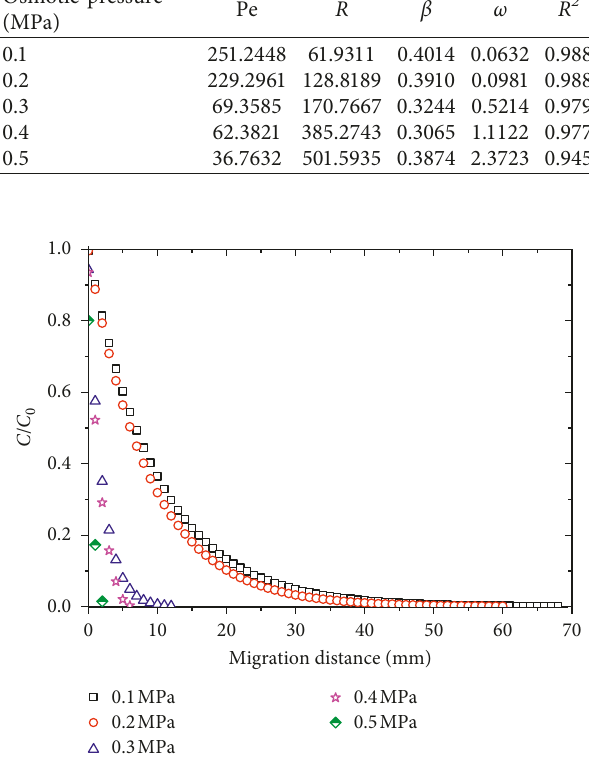
Figure 8: Migration distance simulation